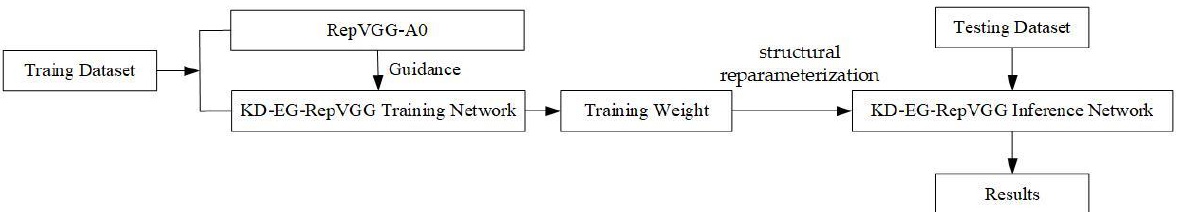
Figure 1. General diagram of defect identification process.